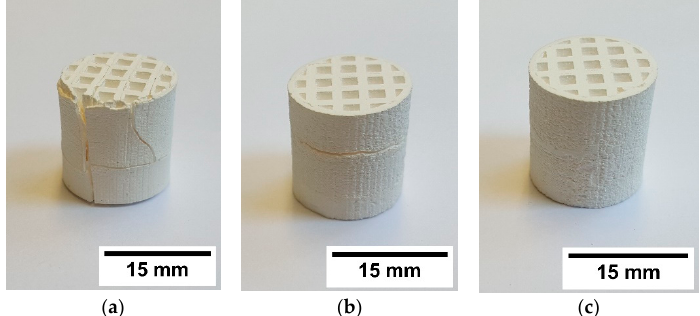
Figure 16. Sintered honeycombs manufactured with different suspensions: ( a ) A&F, ( b ) C&G, and ( c ) C&G.